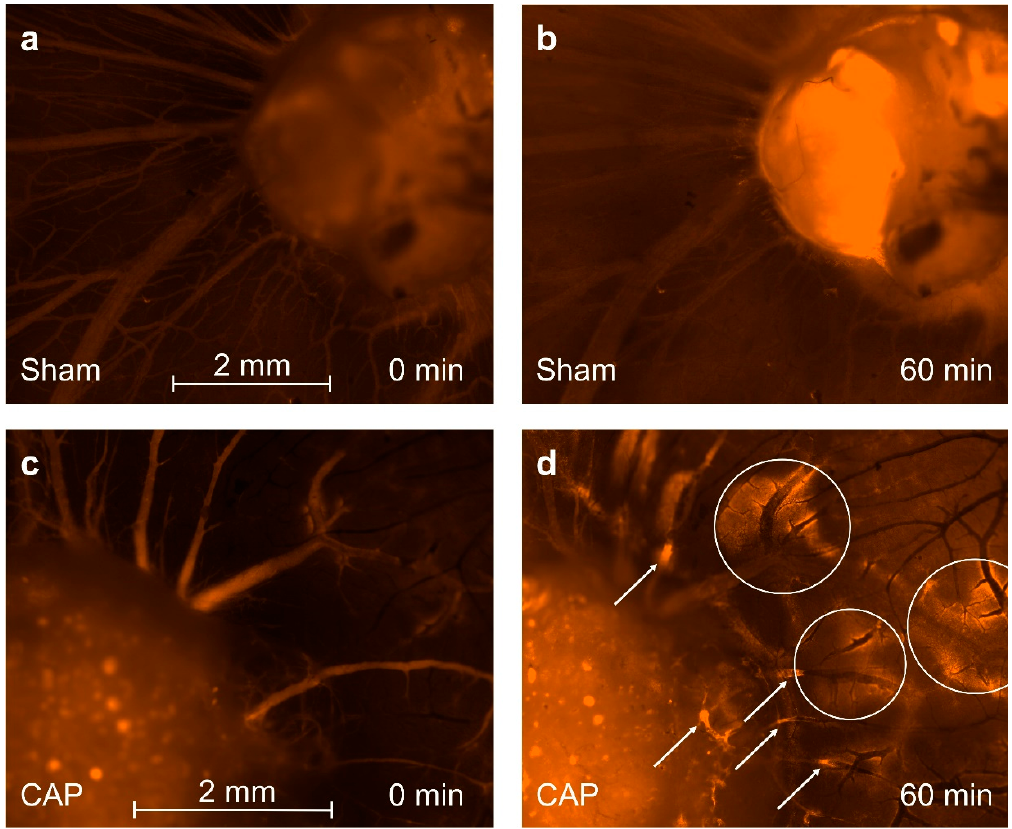
Figure 6. Intravital fluorescence imaging of tumor and surrounding blood vessels. Exemplary image of tumor ( a ) before and ( b ) past 60 min of 60 s sham treatment. A general increase of fluorescence could be observed. Intensification of fluorescence was mainly focused on tumor tissue and the CAM, distancing the tumor approximately 50 µm. Blood vessels surrounding the tumor appeared to be intact. Thrombosis or obliteration of blood vessels did not occur. Tumor ( c ) before and ( d ) past 60 min of 60 s CAP exposure. Increased extravasation of 70 kDa TRITC-dextran could be observed in tumor-associated CAM tissue (white circles). Vascular obliterations and thrombi occurred in several blood vessels (white arrows). Scale bar length 2 mm.